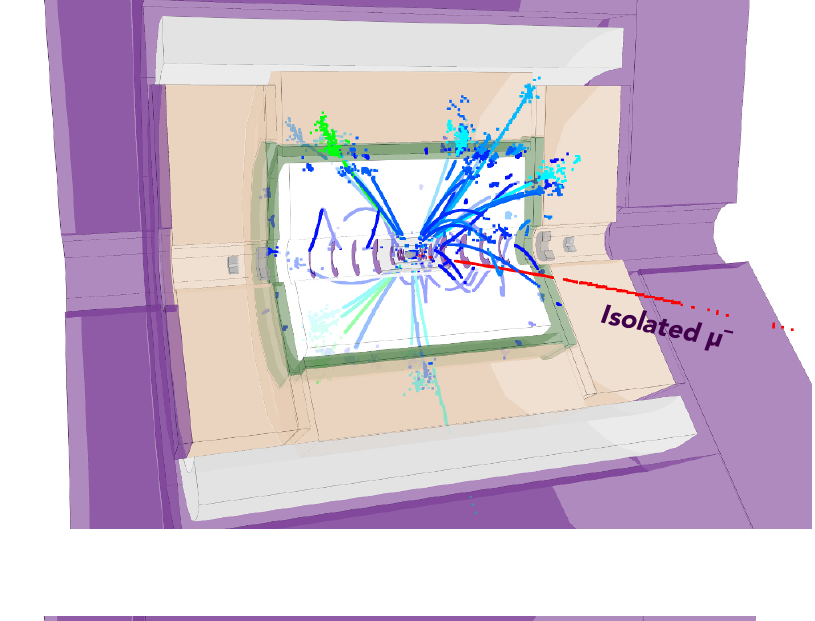
p events in CLIC ILD at s = 380 GeV (top) and m